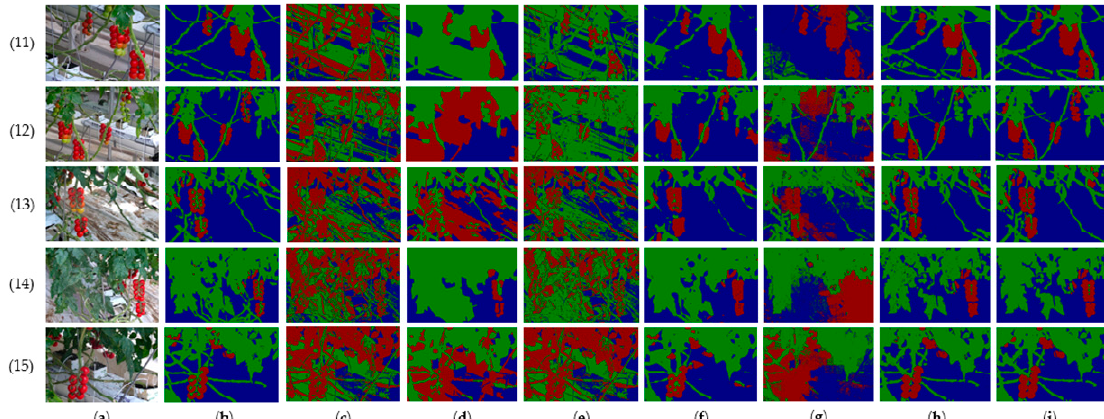
Figure 19. The result of different algorithms with distant shots. Column ( a ) are original images. Column ( b ) are high quality ground-truth. Columns ( c – i ) are the results of several segmentation methods: quantum-behaved particle swarm optimization (QPSO), fuzzy c-means clustering (FCM), pulse coupled neural network based segmentation (PCNN), co-segmentation, the traditional latent Dirichlet allocation (LDA), self-adaptive latent Dirichlet allocation (SA-LDA), and self-adaptive iterative latent Dirichlet allocation (SAI-LDA) , respectively.